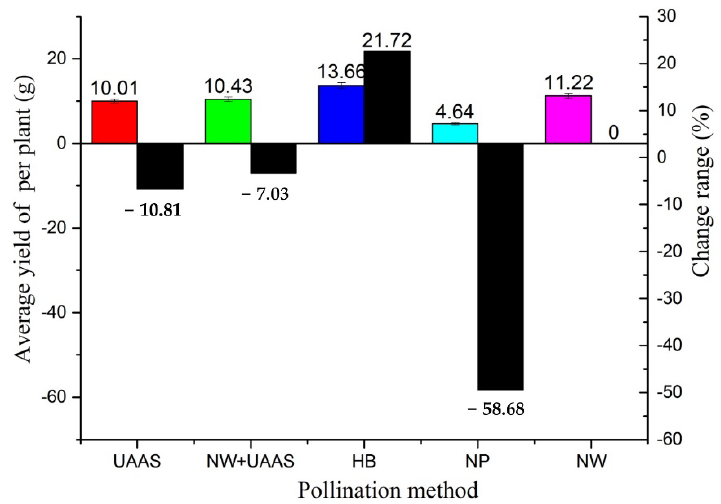
Figure 10. The ARYPPs of different pollination areas and ARYPP change ranges. Note: UAAS—unmanned agricultural aerial system; NW+UAAS—natural wind + UAAS; HB—honeybee; NP—no pollinators; NW—natural wind; ARYPP—average rapeseed yields per plant.